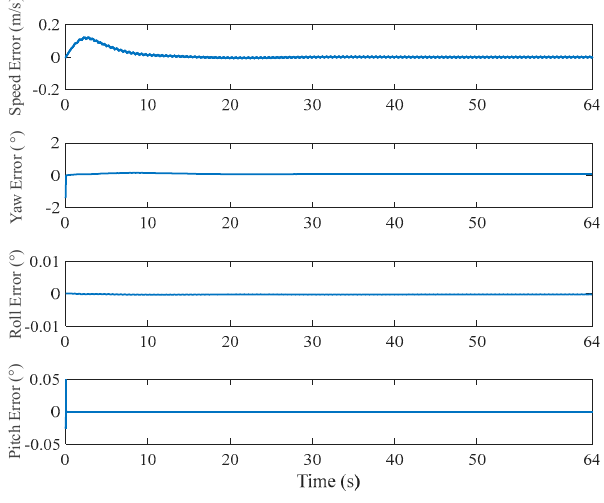
Figure 23. Errors for P 2 tracking.